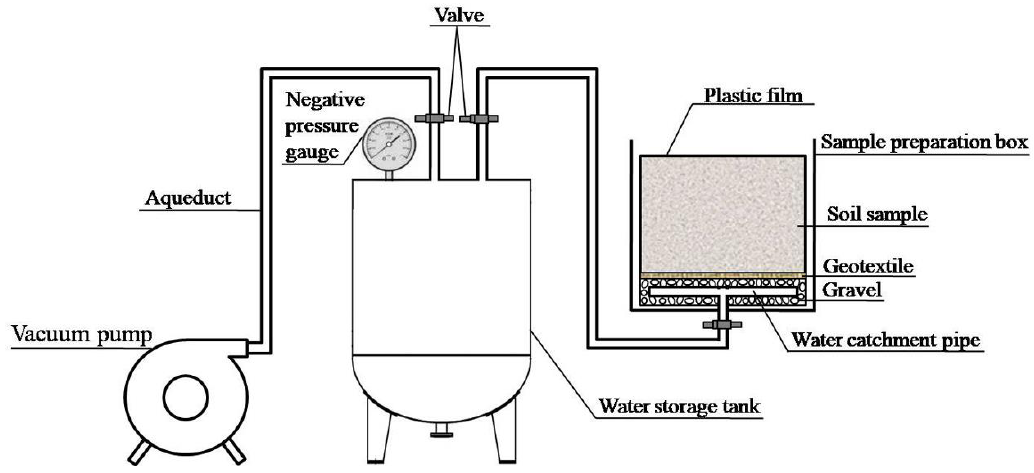
Figure 1. Equipment for preparing clay samples.